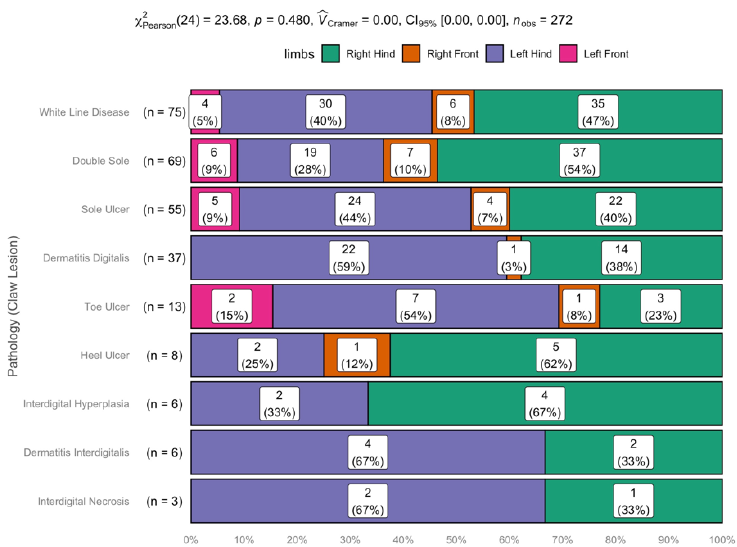
Figure 2. Occurrence of claw lesions according to pathologies in cattle diagnosed with left displacement of the abomasum (LDA) and claw lesions (LDA + CLAW). A total of 272 claw diseases was diagnosed in 117 cattle. Pathologies are given as percentage (%) and numbers in each limb. There was no significant association between particular claw lesions and a particular limb. X 2 Pearson stands for Pearson’s Chi-square statistics and V cramer for the effect size of Pearson’s Chi-square test. CI 95% are the 95% confidence intervals for V cramer . n obs stands for the number of observations.